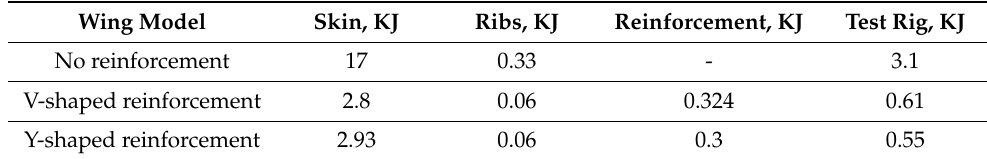
Table 3. Maximum internal energy by the